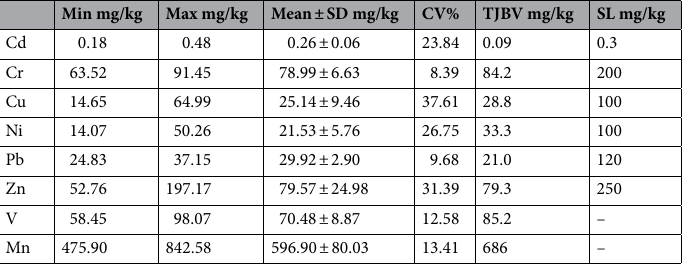
Table 2. Statistical description of heavy metals in soils of the research area. –: no data available, SD standard deviation, CV% coefficient of variation, TJBV soil background values of Tianjin, SL screening values in CNS (GB 15618-2018) (6.5 < PH ≤